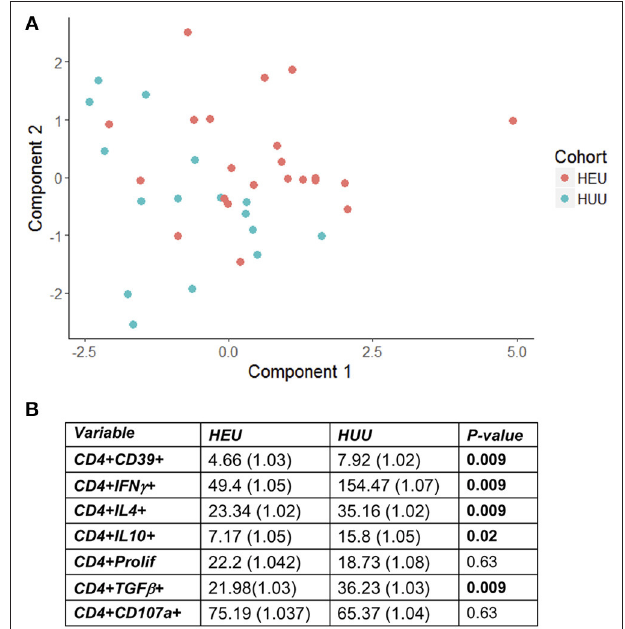
FIGURE 1 | HEU and HUU functional CD4 + T cell responses. Data were derived from PBMC of 22 HEU and 17 HUU after stimulation with SEB and mock. Results were expressed as the ratio between SEB and mock stimulation. (A) shows the PCA distribution of the results. (B) shows results of the regression